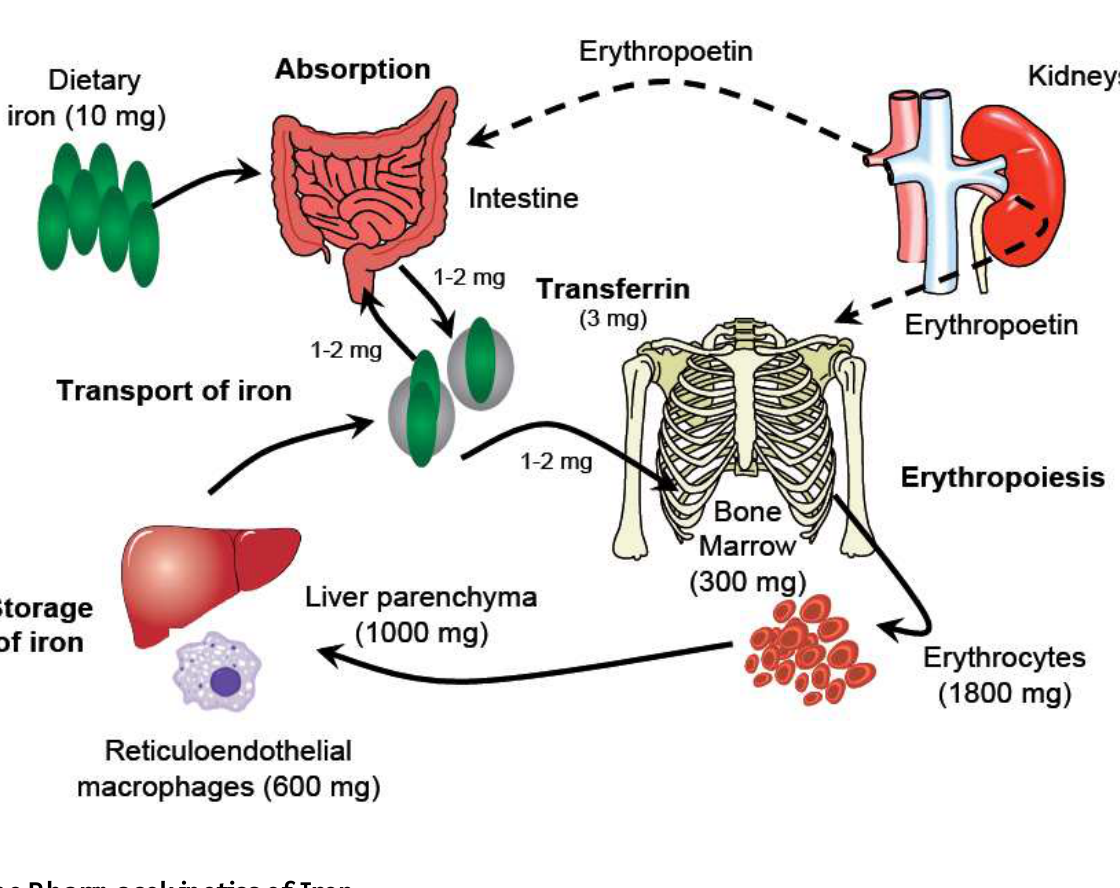
Figure 1. Schematic representation of iron metabolism. Under normal conditions, the iron in the body is in a dynamic equilibrium between different compartments (solid